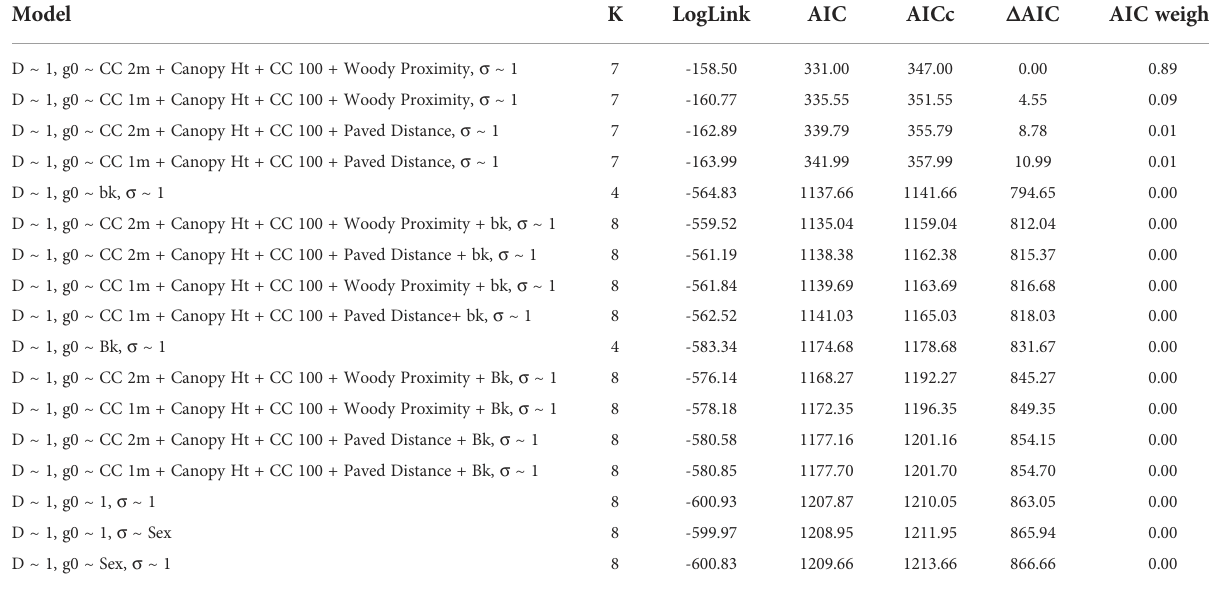
TABLE 2 Model selection results for the estimation of ocelot ( Leopardus pardalis pardalis ) density and encounter probabilities (g0, s ) on the East Foundation ’ s El Sauz Ranch in Willacy and Kenedy counties, Texas, USA from September 2020 to May 2021. .